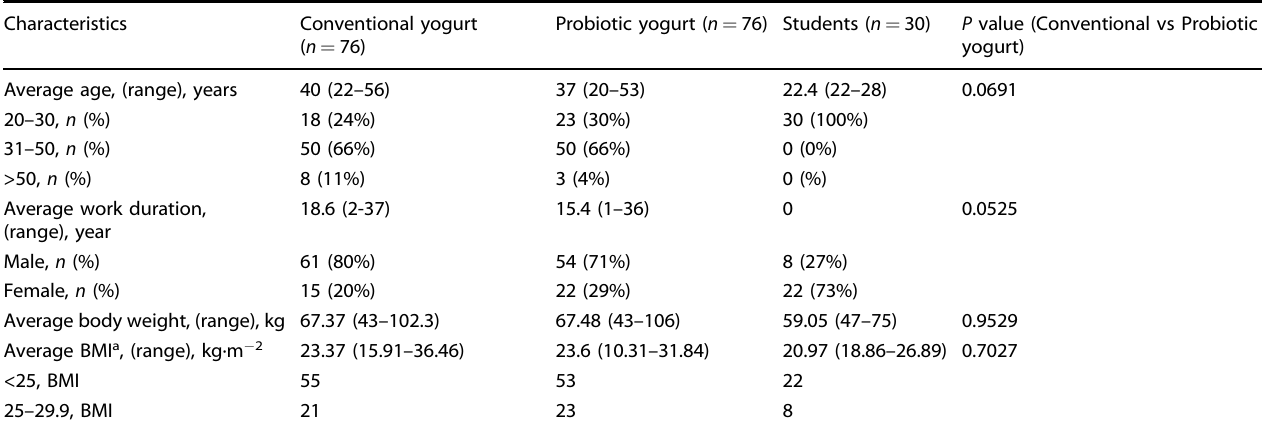
Table 1. Demographics and baseline characteristics of the participants.